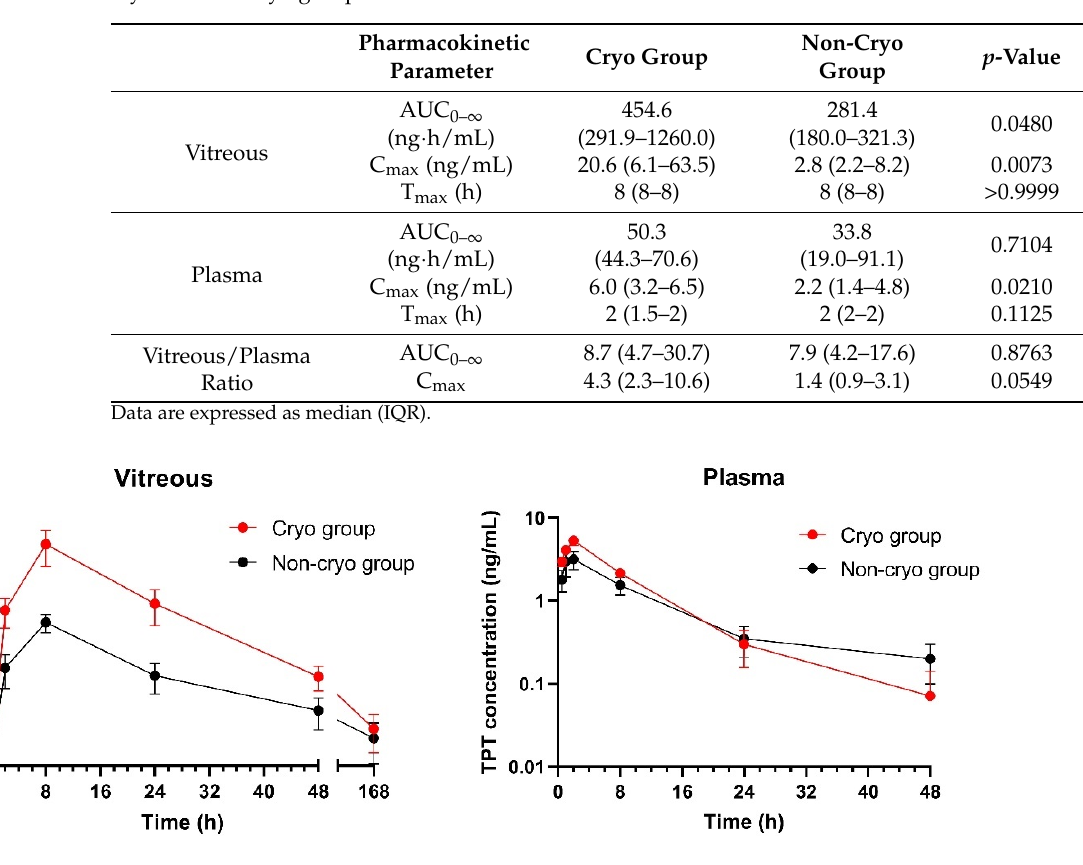
Figure 4. Vitreous and plasma TPT concentration–time profiles in the cryo and non-cryo group. Data are expressed as means ± SEM.